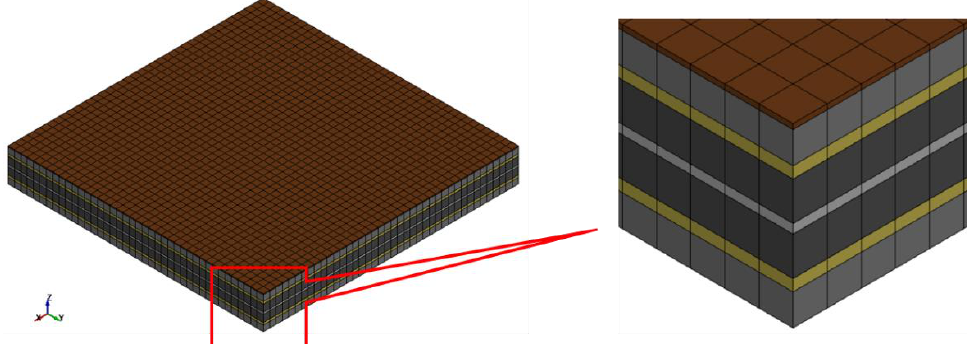
Figure 8. A battery cell model using the sandwich modelling technique .